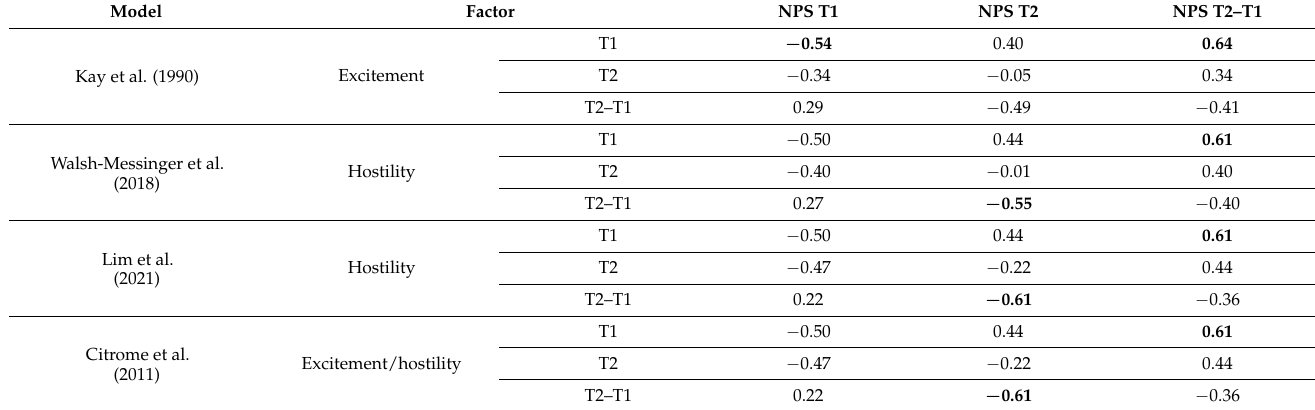
Table 5. The Pearson’s r product–moment correlation coefficients for REH group: NPS T1, NPS T2, and NPS T2–T1 correlated with excitement/hostility factors. Strong correlations for absolute values of r > 0.5 ( p < 0.05) were bolded.